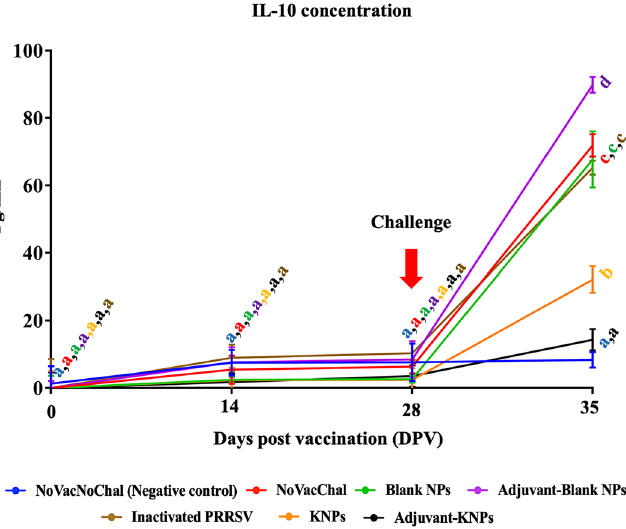
Figure 5. Quantification of porcine IL-10 concentration in the supernatant of stimulated PBMCs. The data represents the mean ± SEM. Different lowercase letters indicate significant differences between groups ( p < 0.05).